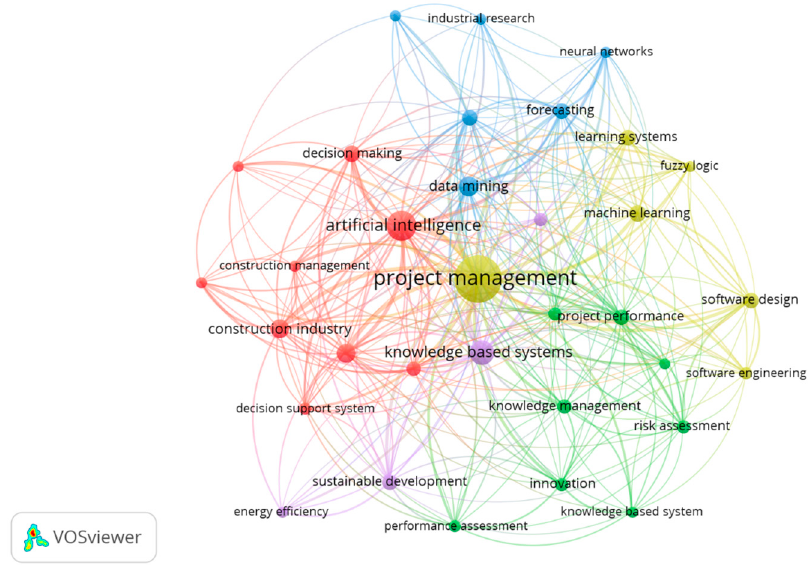
Figure 10. Clusters identified in the Measurement domain.